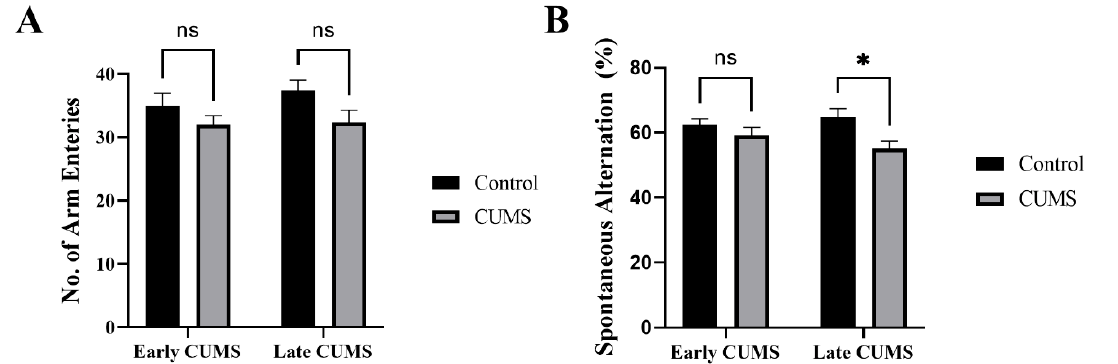
Figure 6. The effect of early and late CUMS on short-term spatial memory in the Y-maze task: ( A ) number of arm entries and ( B ) spontaneous alternation. Two-way ANOVA was used, followed by Š í d á k’s multiple-comparisons test. (*) indicates a significant difference between the treated CUMS and the control group at p > 0.05. ns: not